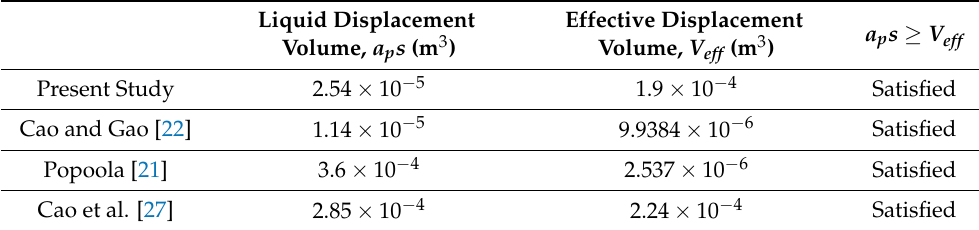
Table 1. Critical displacement volume